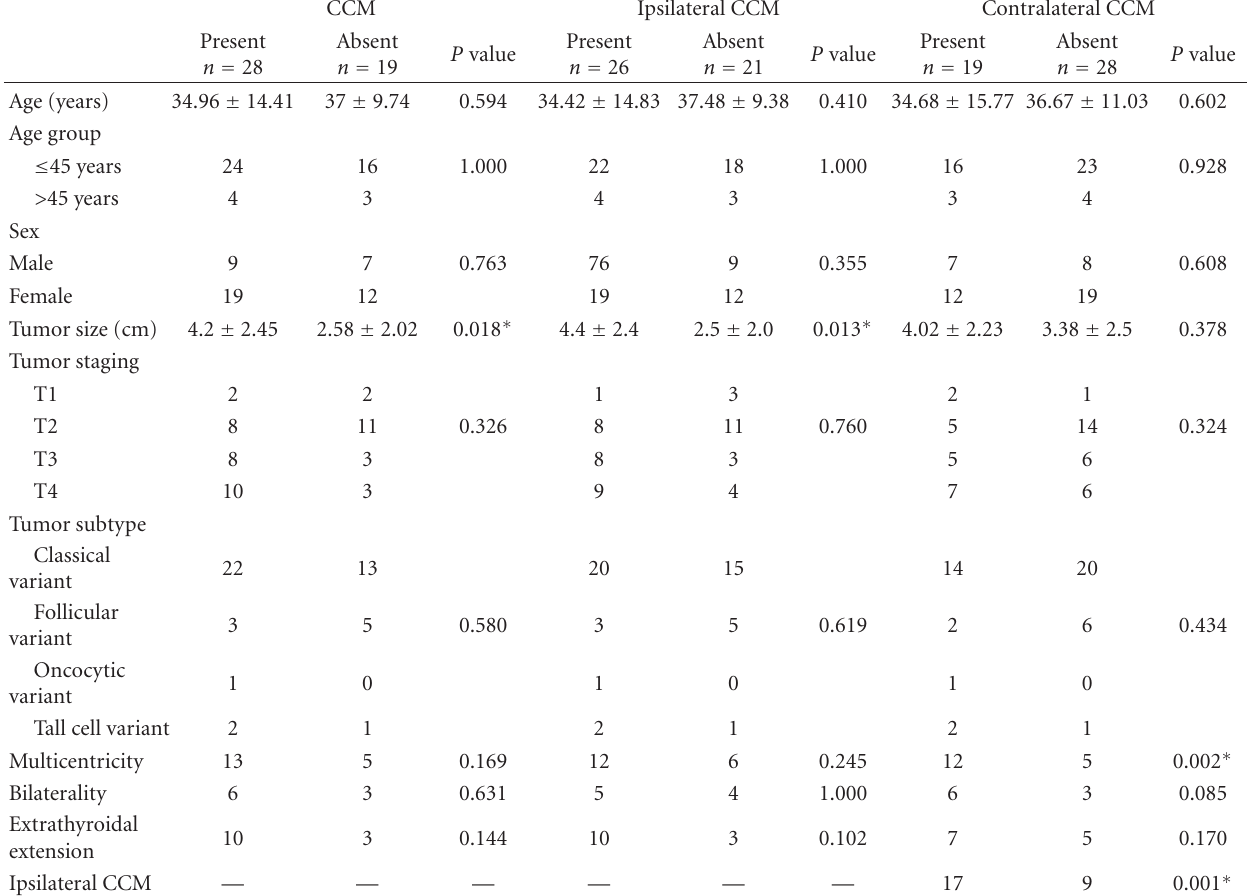
Table 3: Univariate analysis of central compartment lymph nodes metastasis (CCM), ipsilateral CCM and contralateral CCM with known risk factors.